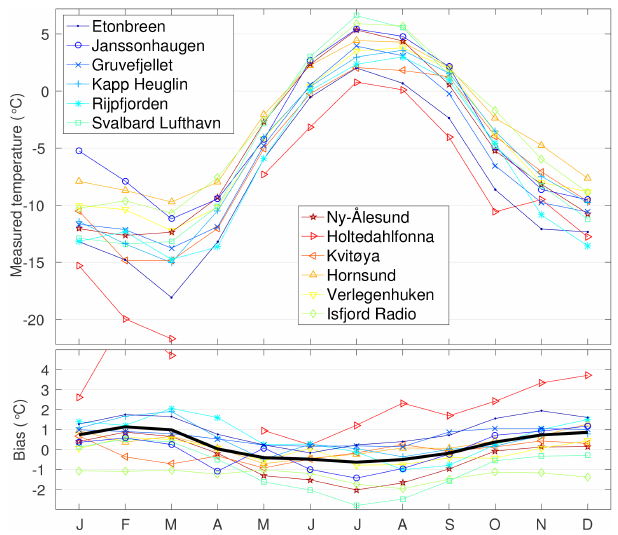
Figure 5. Observed monthly mean 2m air temperatures (up- per panel) and biases given by downscaled minus observational monthly averages (lower panel). Bold black line is the average over the 12